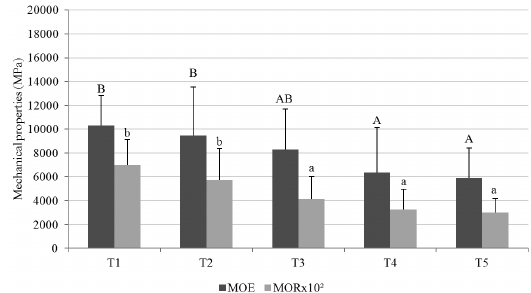
Figure 2. Mean values of V according to the attack level by xylophagous organisms. Means followed by the same letter, lowercase and uppercase, are not statistically different at 5% of the probability of error (Fisher LSD test).